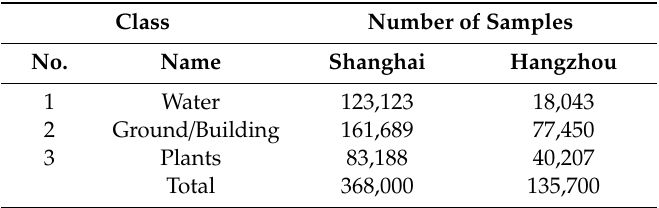
Table 3. Land cover classes and the number of samples for Shanghai–Hangzhou.